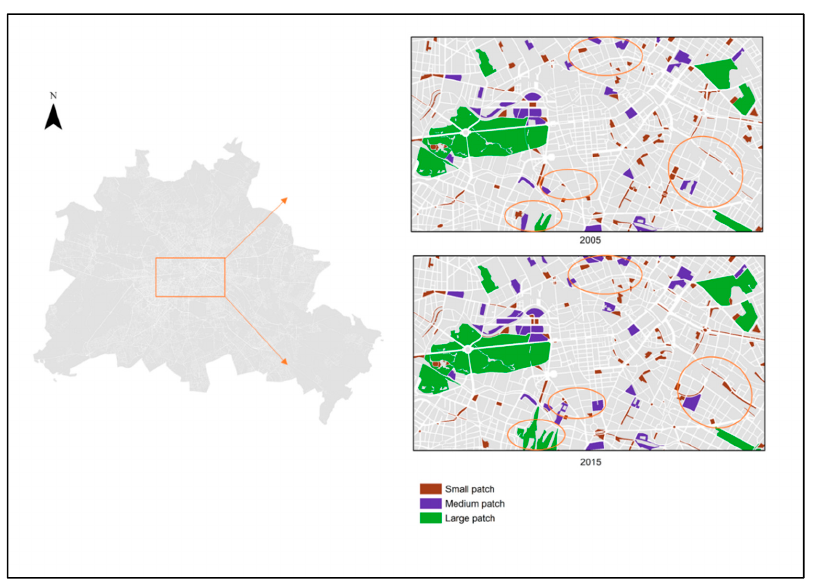
Figure 6. Green space in the city centre. Figure 6.